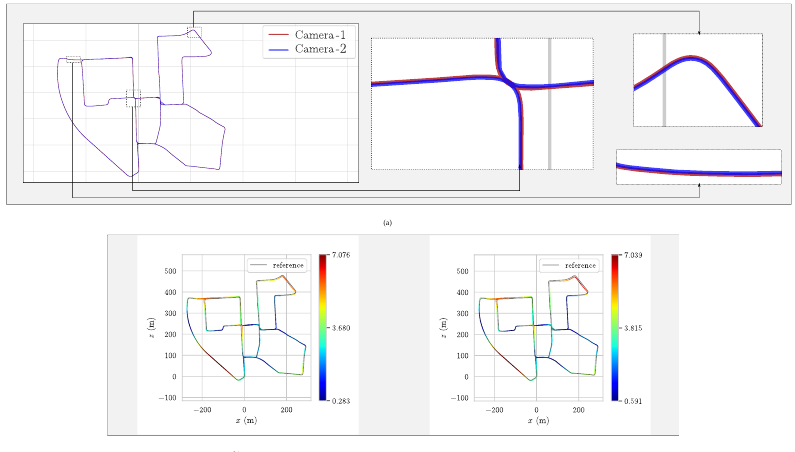
Figure 7. ( a ) The multi-camera trajectories using the proposed method in KITTI-00. ( b , c ) The comparison of the left and the right camera with the ground truth data on KITTI-00. The color bar represents the error of the estimated trajectory compared to the ground truth data. As the trajectory turns into blue, the error gets